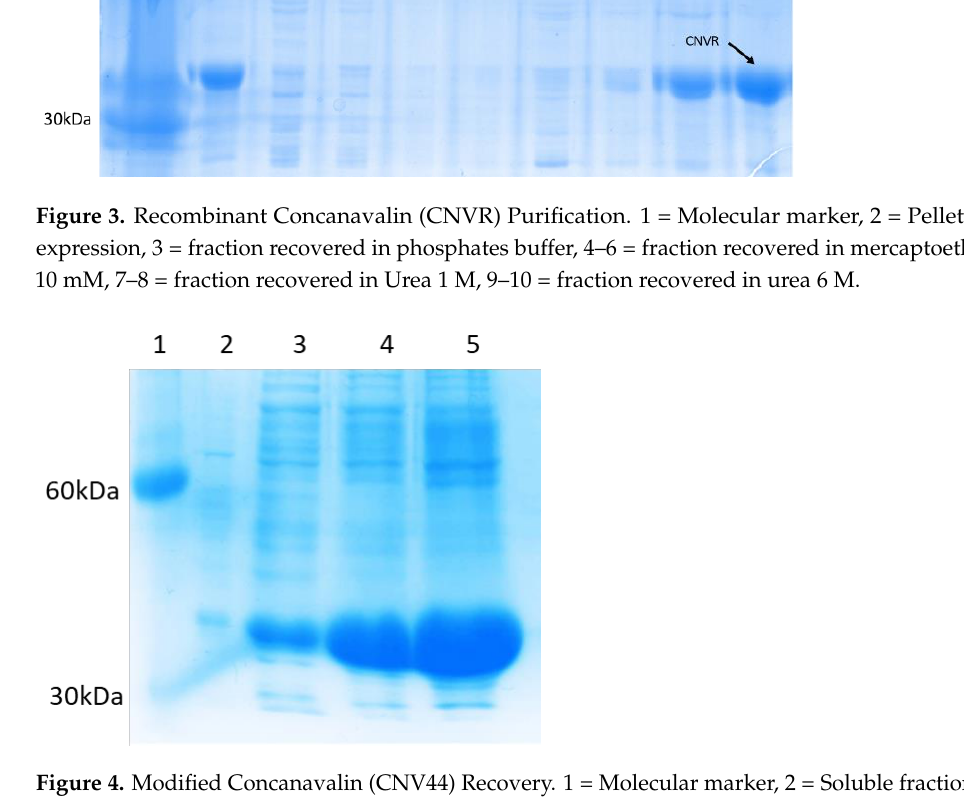
Figure 3. Recombinant Concanavalin (CNVR) Purification. 1 = Molecular marker, 2 = Pellet after expression, 3 = fraction recovered in phosphates buffer, 4–6 = fraction recovered in mercaptoetha- nol 10 mM, 7–8 = fraction recovered in Urea 1 M, 9–10 = fraction recovered in urea 6 M.